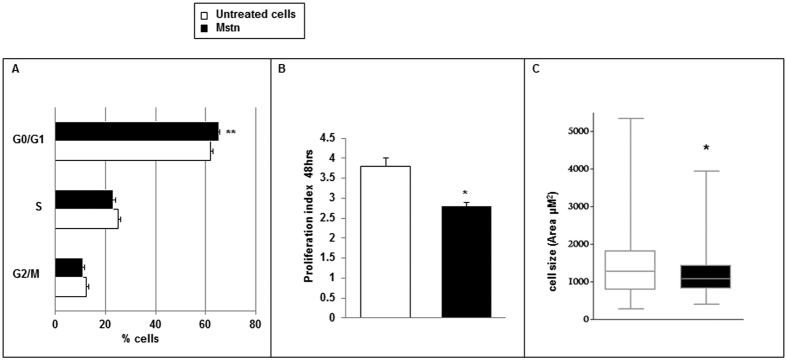
Effects of Myostatin (Mstn) on A7r5 cell cycle (A), proliferation index (B) and cell size (C). A 24 hour Mstn treatment caused an increase of G0/G1 phase as revealed by propidium iodide staining and flow-cytometry reading. At 48 hours theproliferation rate as revealed by CFSE-DA assay and the cell size were reduced. Data shown as mean ± SEM (A,B) and median ± IQR (C). *p < 0.05, **p < 0.01 vs. untreated cells (n = 3).